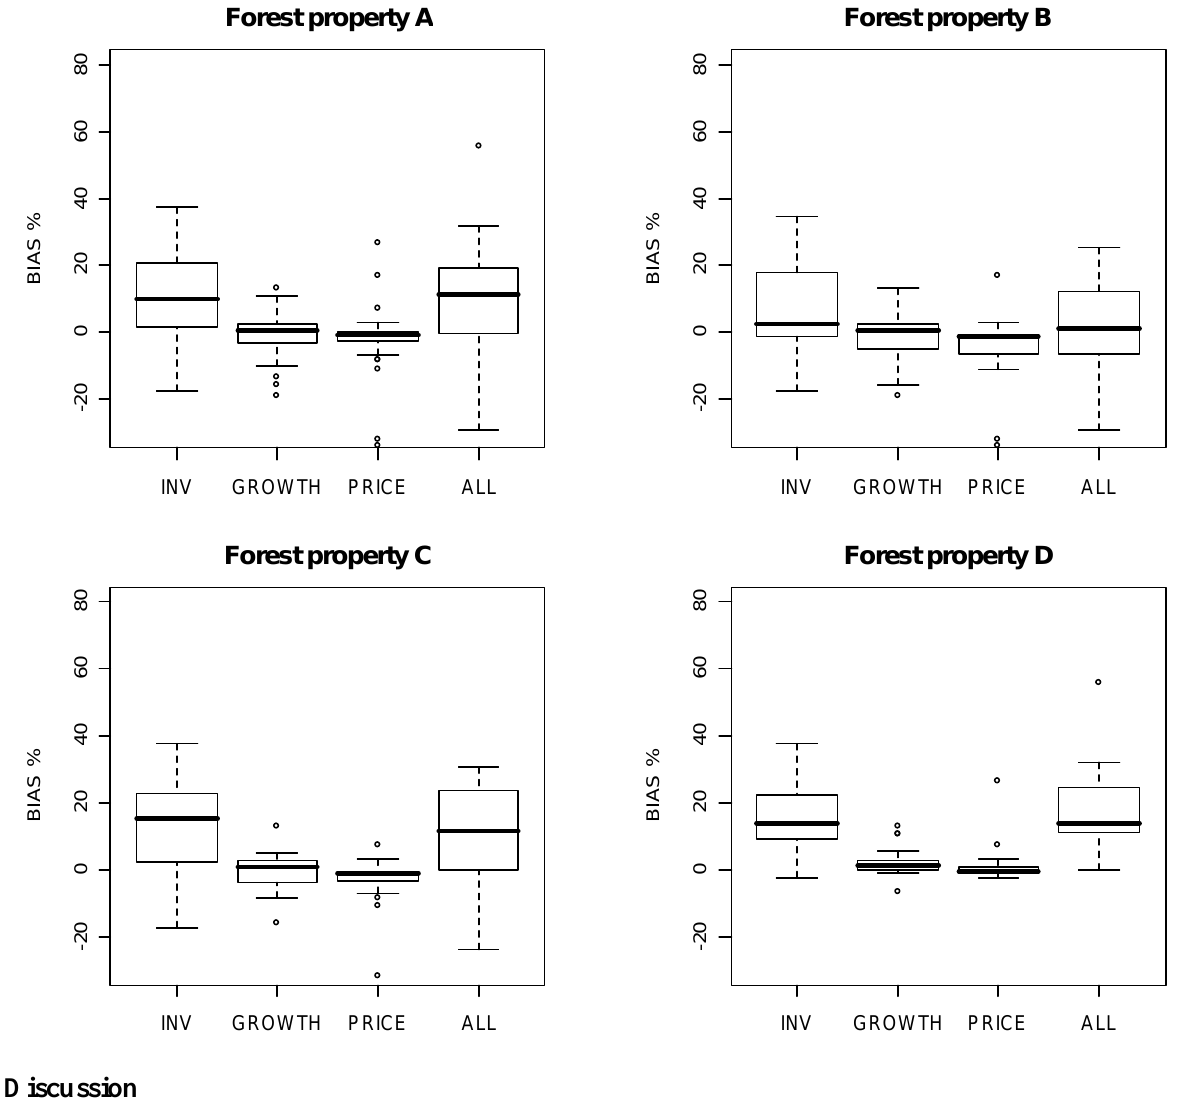
Figure 3. Variation in relative BIAS within stands of forest properties (25 ha, interest rate 3%). INV = U , GROWTH = U , PRICE = U , ALL = combined inv growth price